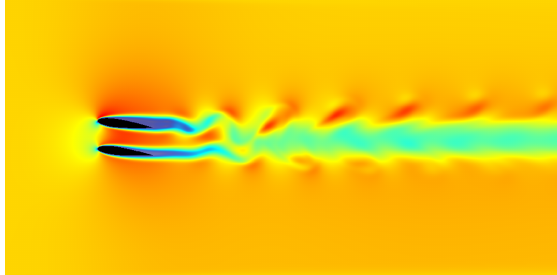
Figure 7. ELBE simulation of two NACA profiles to answer the question which of the two profiles generates more lift. The flow is coming from the left (velocity boundary condition). 512 times 256 lattice nodes were used, yielding a total of 131,072 lattice